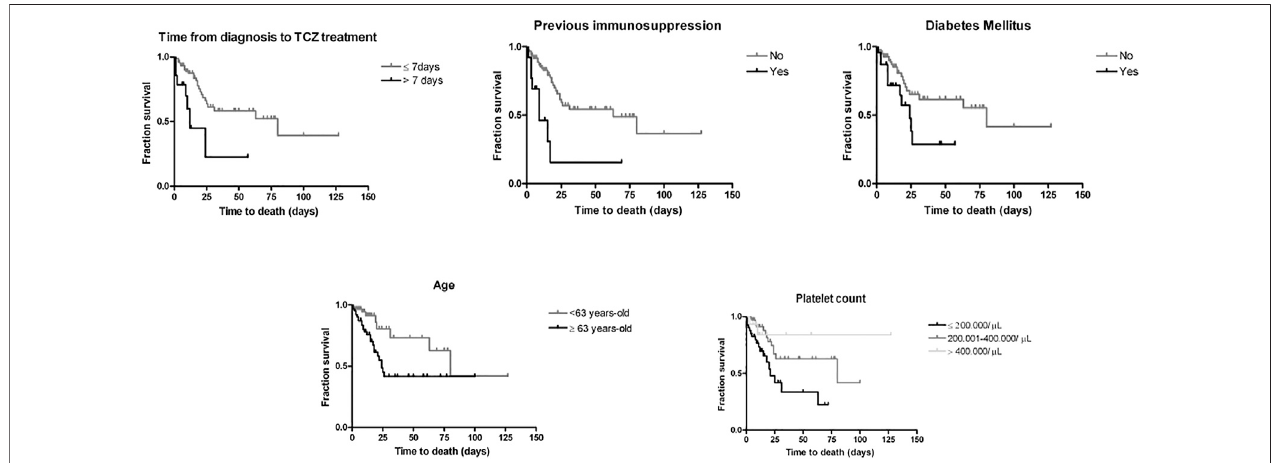
FIGURE 1 | Survival curves of the variables associated with time to death. Censored (discharged by the end of follow-up) subjects are indicated on the curve as tick marks.